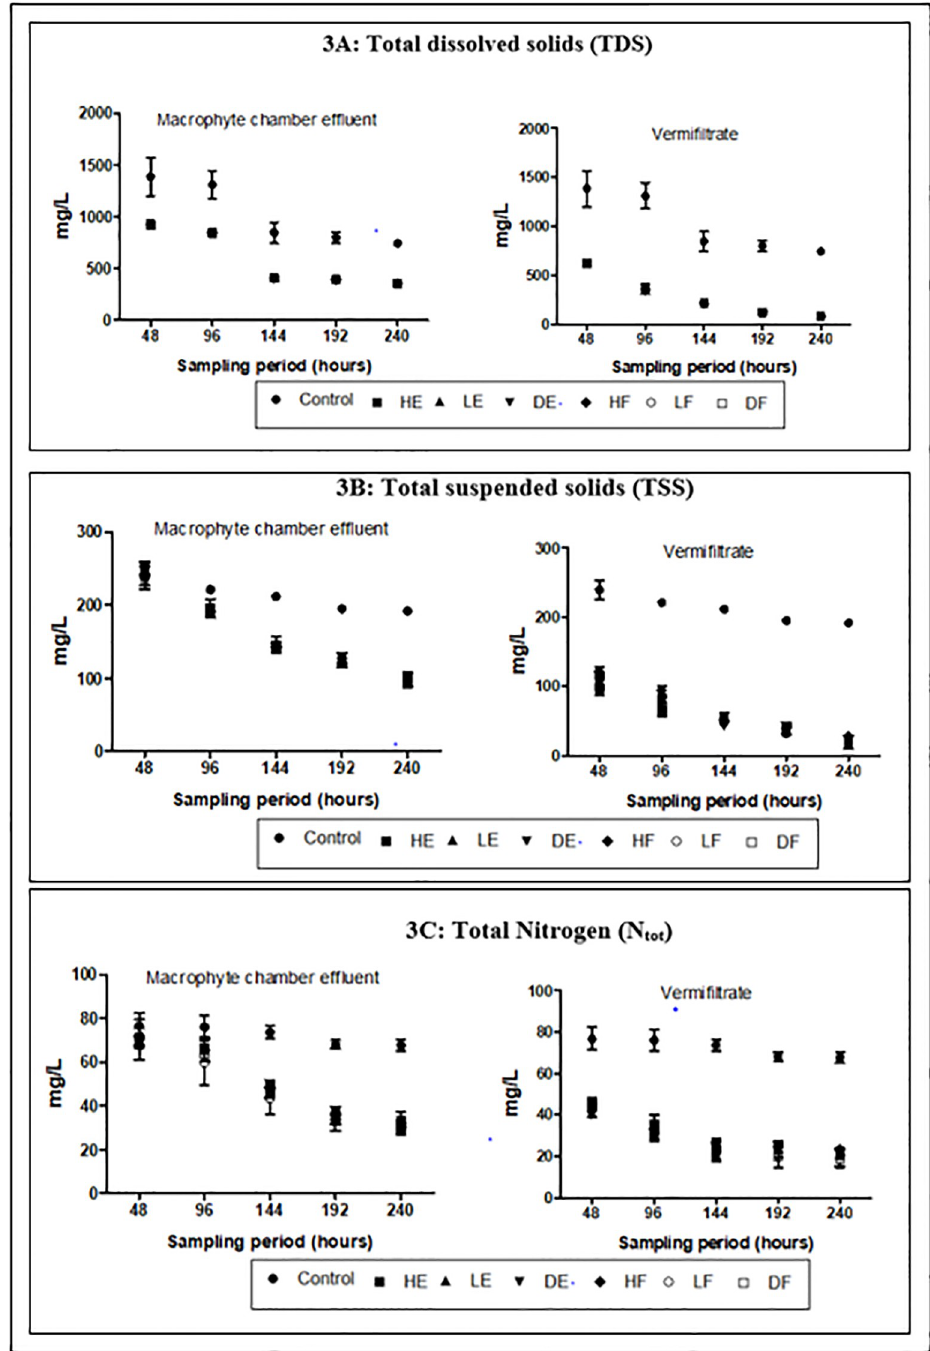
Fig 3. Physicochemical characteristics of effluent (A) TDS (B) TSS (C) N tot . https://doi.org/10.1371/journal.pone.0281953.g003 62% in the macrophyte chamber effluents and 90%– 94% in vermifiltrates). Aside the first sampling points in the macrophyte chamber that showed no significant reductions (p > 0.05), the reductions in the experimental setup effluents were significant (p < 0.05) in all sampling points when compared to the control.